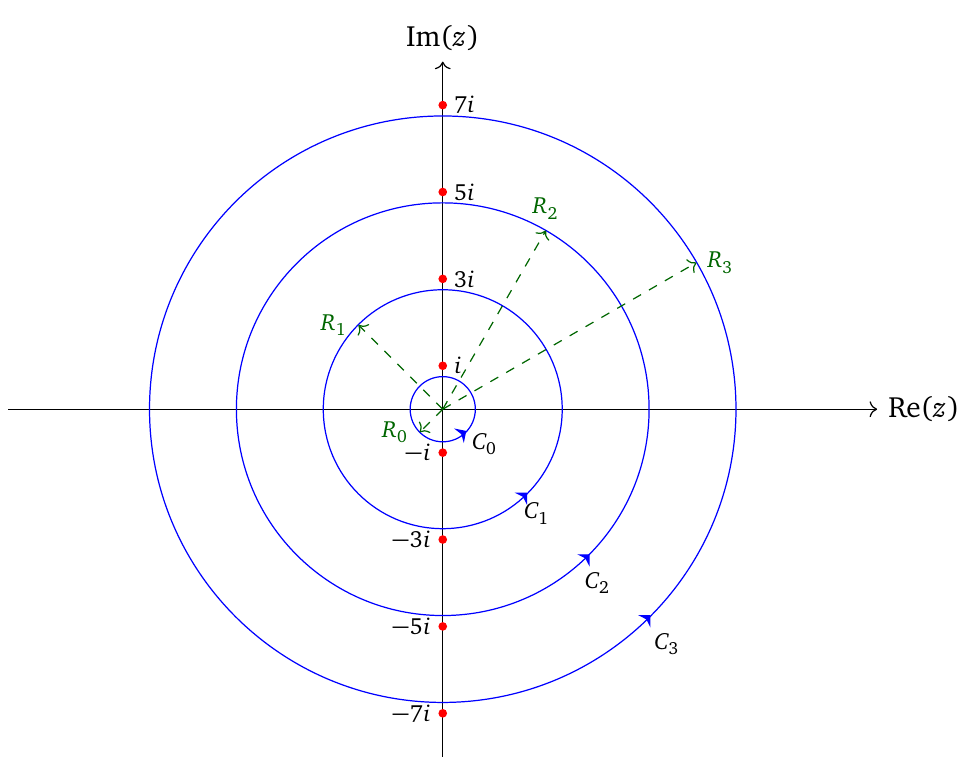
Z , are shown as red points along the π z Figure 3. The poles of sech , i.e., ζ n = ( 2 n + 1 ) i , n 2 ∈ imaginary axis. The plot also shows the several concentric blue circles C N with positive orientation π (cid:0) (cid:1) z , i.e., ζ 2 n + 1 ) i , n Z , are shown along the imaginary axis. The plot n = ( and radii R N that do not intersect these 2 ∈ with radii R that do not intersect these poles. N N (cid:0) (cid:1)